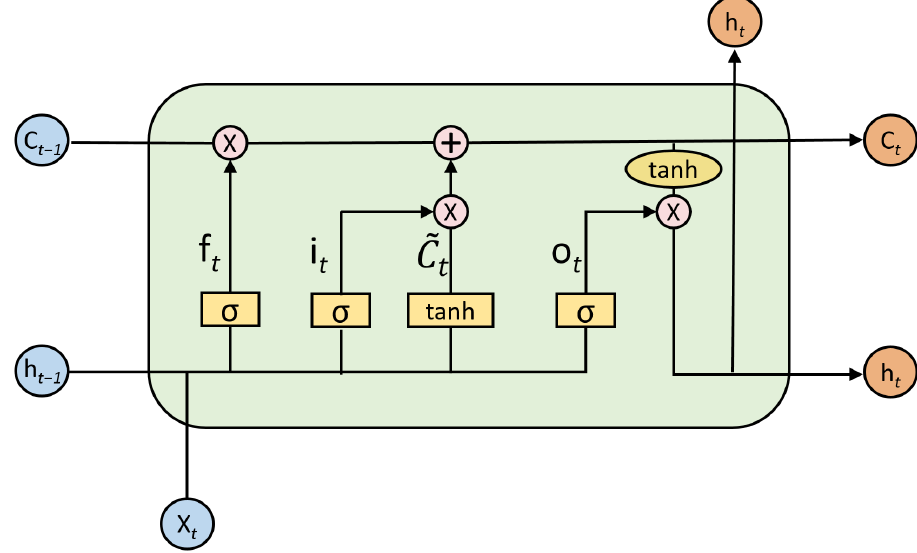
Figure 1. Internal structure of the LSTM